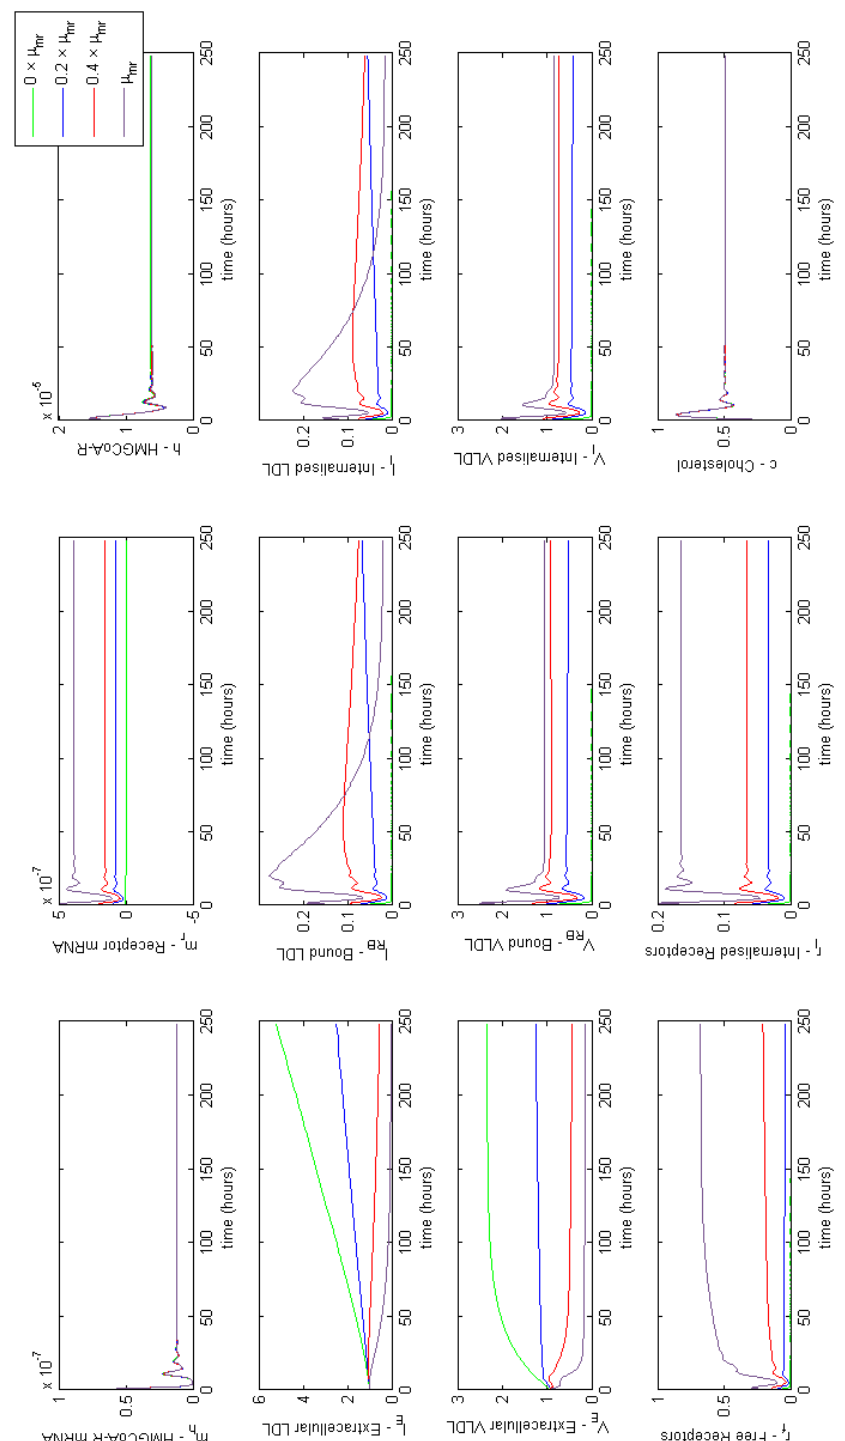
Figure A1. Familial Hypercholesterolaemia Class I; LDLR are not synthesised correctly, affecting parameter µ mr . Results show a lack of receptors has a significant impact on extracellular LDL and VLDL